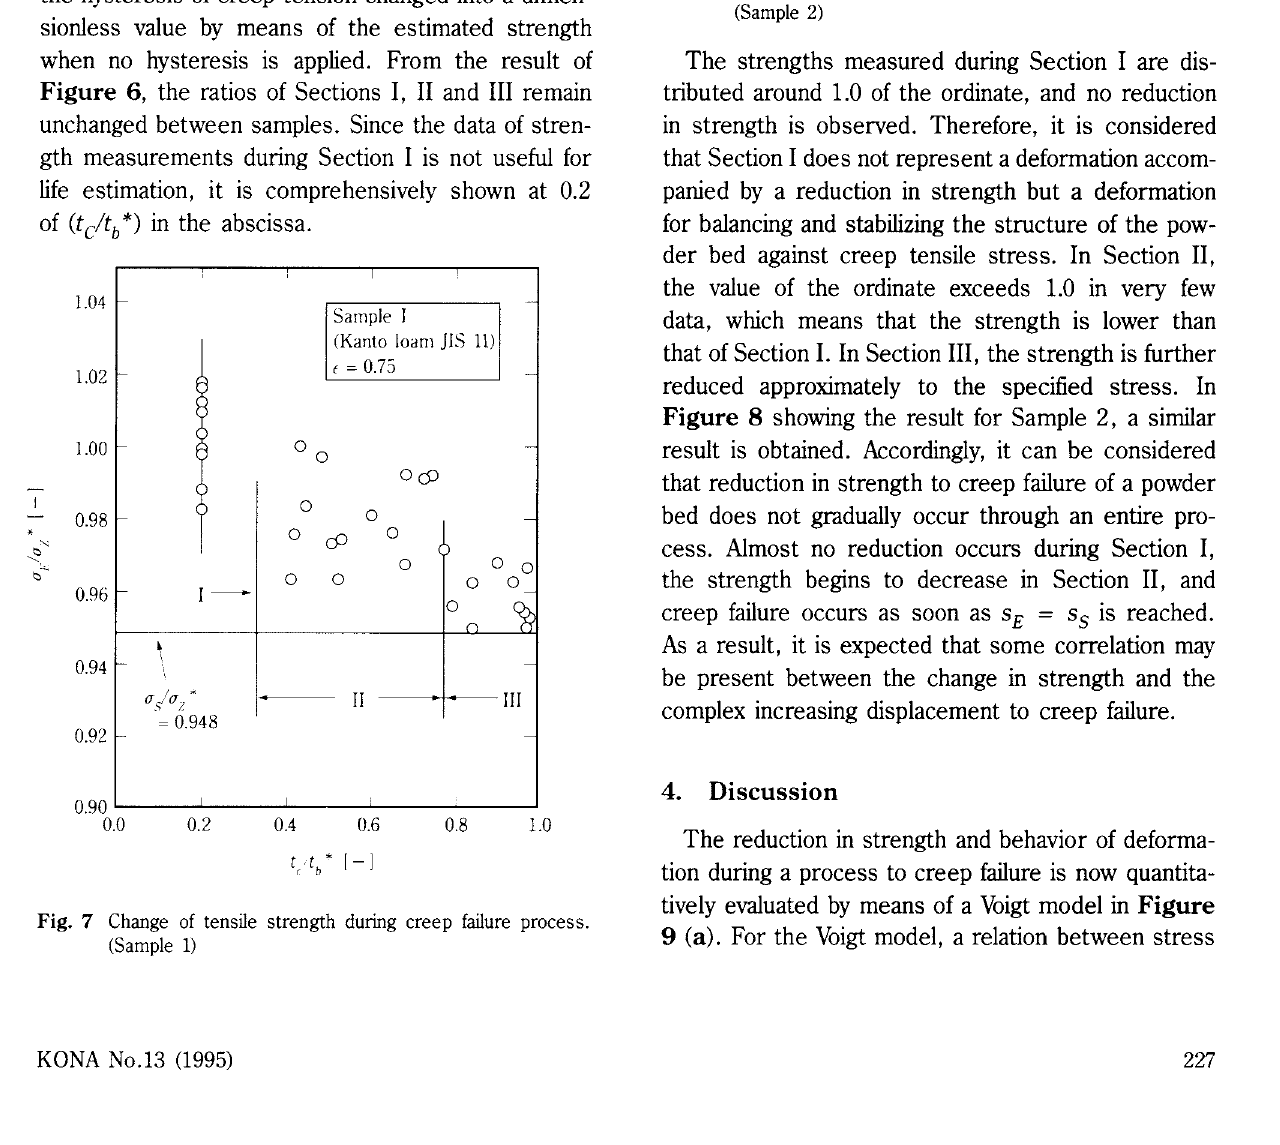
Fig. 8 Change of tensile strength during creep failure process. (Sample